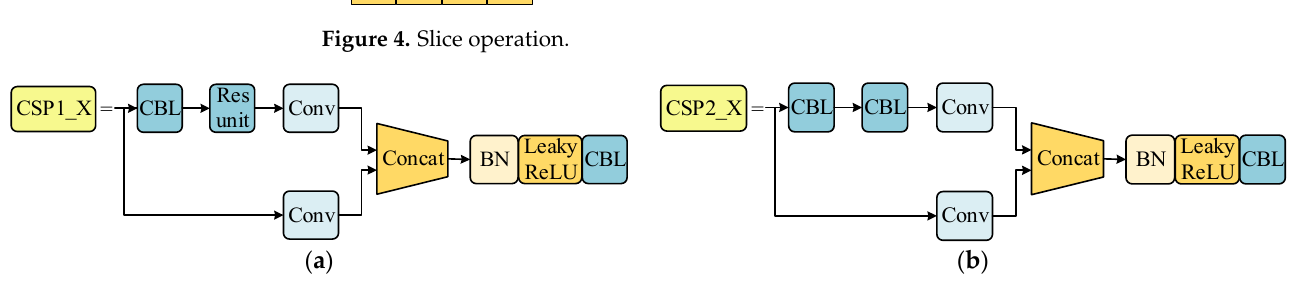
Figure 5. CSP structure. ( a ) CSP1_X. ( b ) CSP2_X.